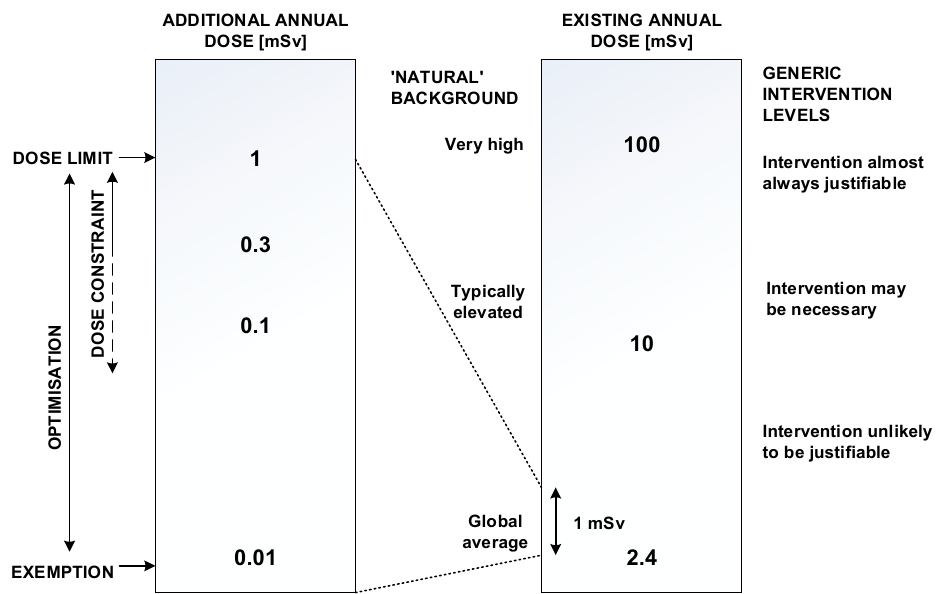
Figure 3. Schematic representation of the individual dose restrictions in terms of additional annual dose vis à vis the reported levels of natural background exposure in terms of existing annual